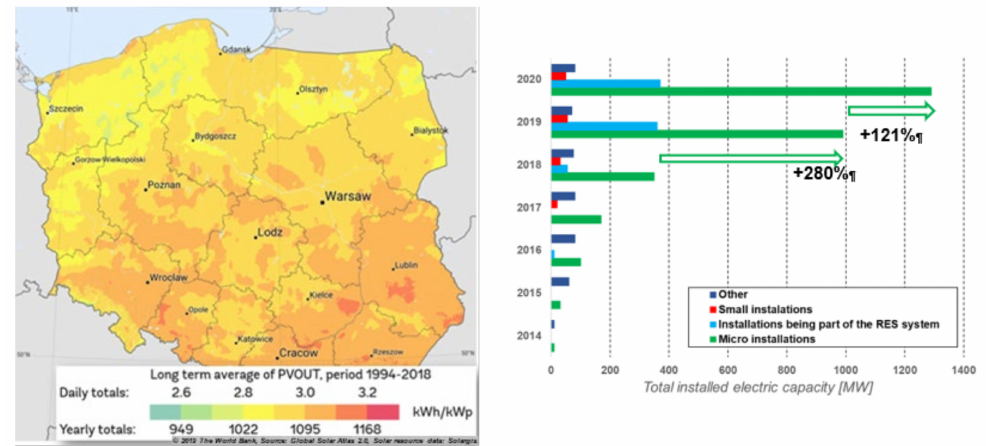
Figure 6. Average annual sum of photovoltaic (PV) power potential [51] and the development of micro installations in Poland